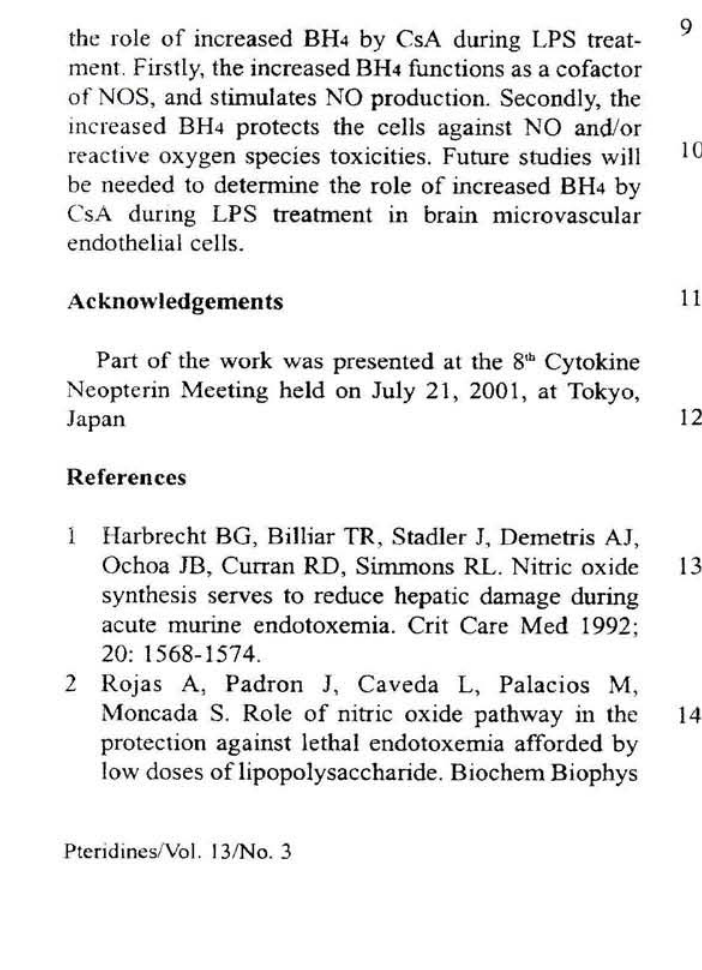
Figure 3. Effects of CsA on the induction of iNOS and GTPCH mRNA levels during LPS treatment. The cells were incubated with various concentrations of CsA (0.1-10 μΜ) in the presence of LPS (100 ng/ml) for 8 h, and then total RNA was extracted from the cells. The total RNA (0.2 was amplified by RT-PCR using specific primers for GTPCH, iNOS and GAPDH, respectively. DNA size markers in the left- most lane correspond to (bp): 506, 396, 344 and 298. the role of increased BH4 by CsA during LPS treat- ment. Firstly, the increased BH4 functions as a cofactor of NOS, and stimulates NO production. Secondly, the increased BH4 protects the cells against NO and/or reactive oxygen species toxicities. Future studies will be needed to determine the role of increased BH4 by CsA during LPS treatment in brain microvascular endothelial